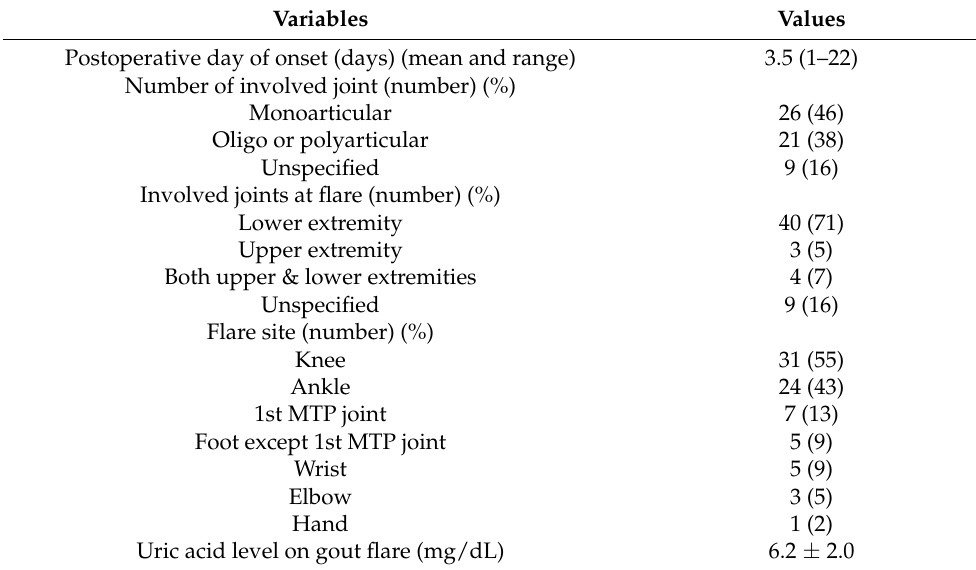
Table 4. Clinical characteristics of patients with postsurgical gout flare.